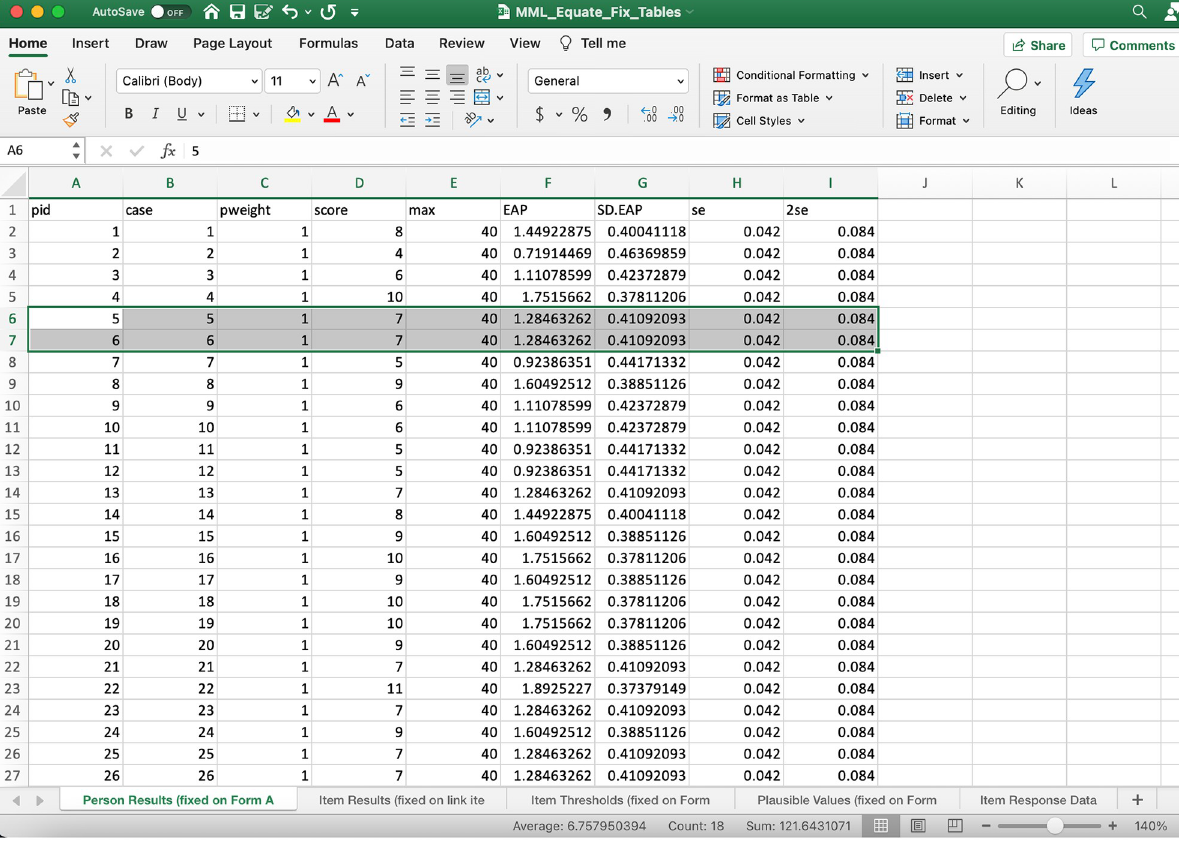
Fig 13. Output.xlsx file from fixed equating